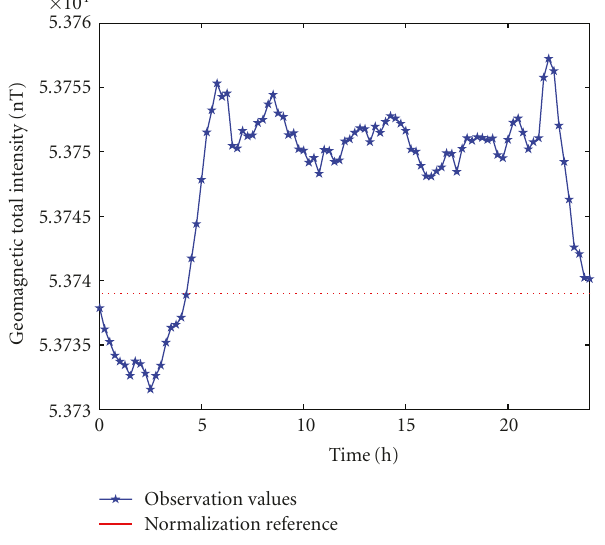
Figure 11: Results after the combination algorithm and the traditional